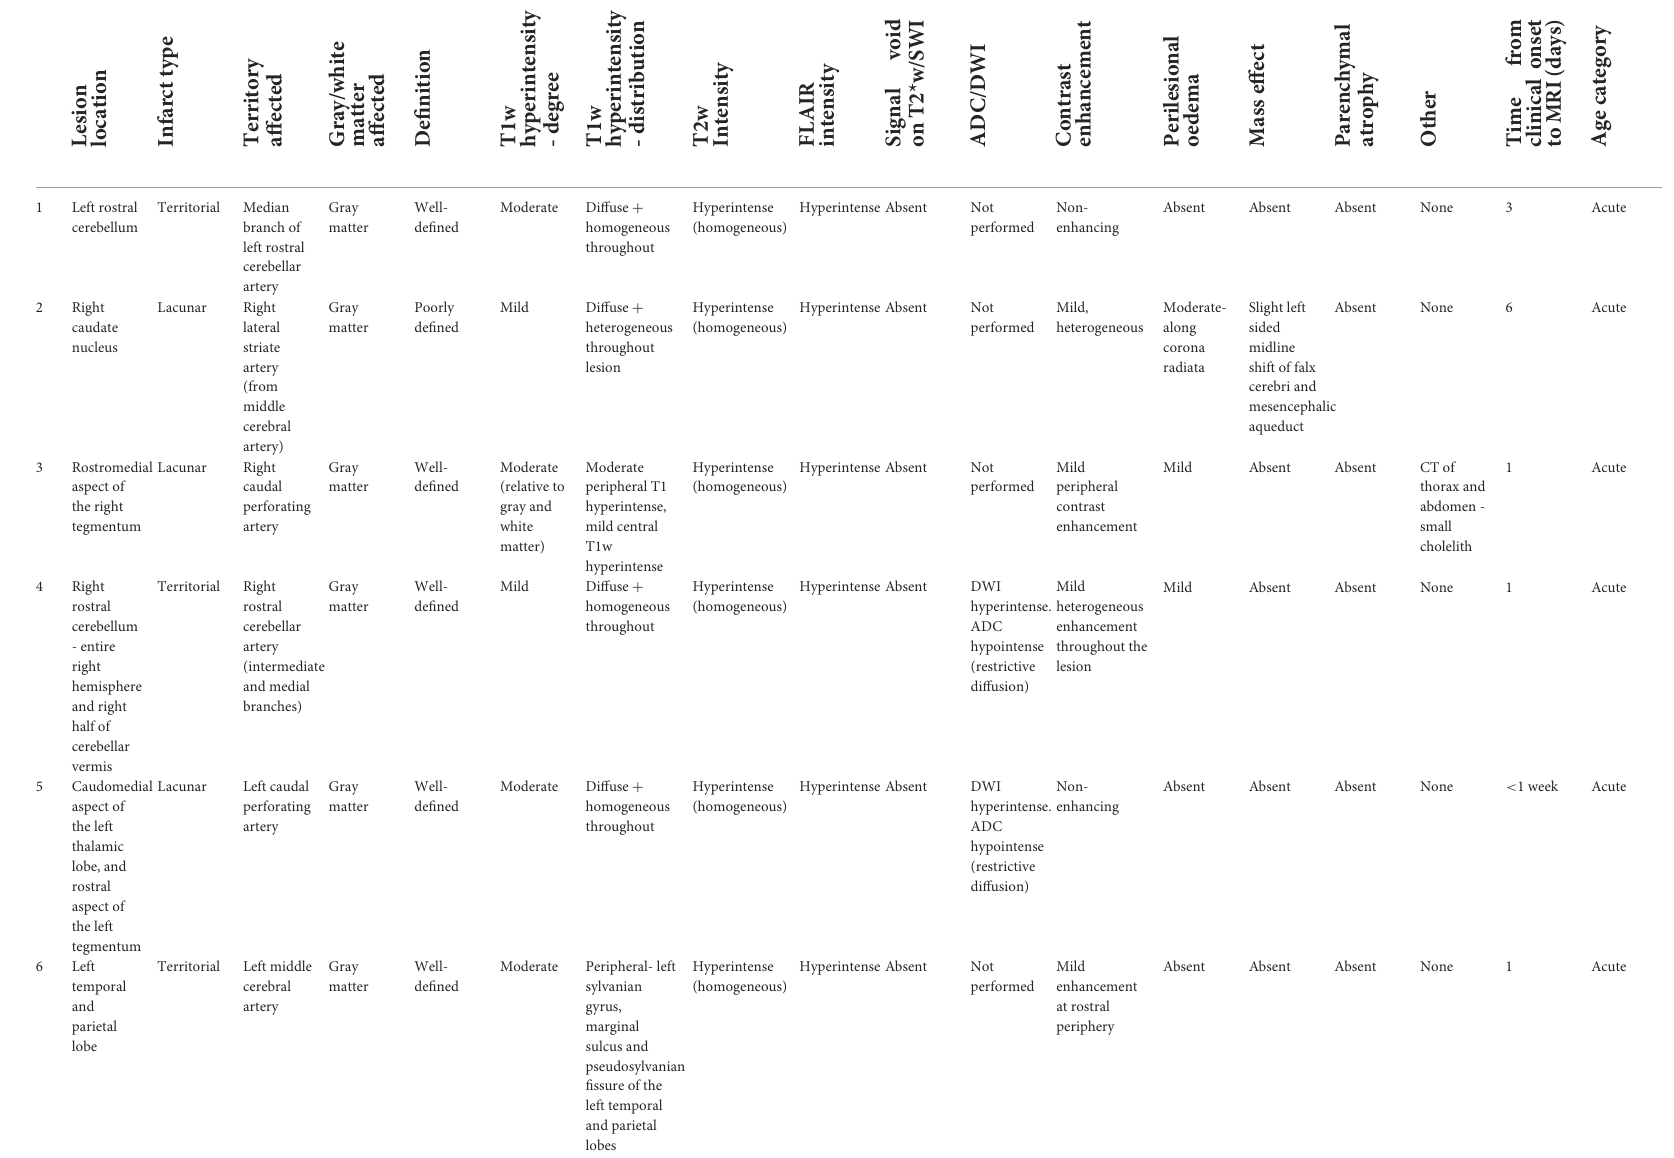
TABLE 4 Findings of MRI assessment.